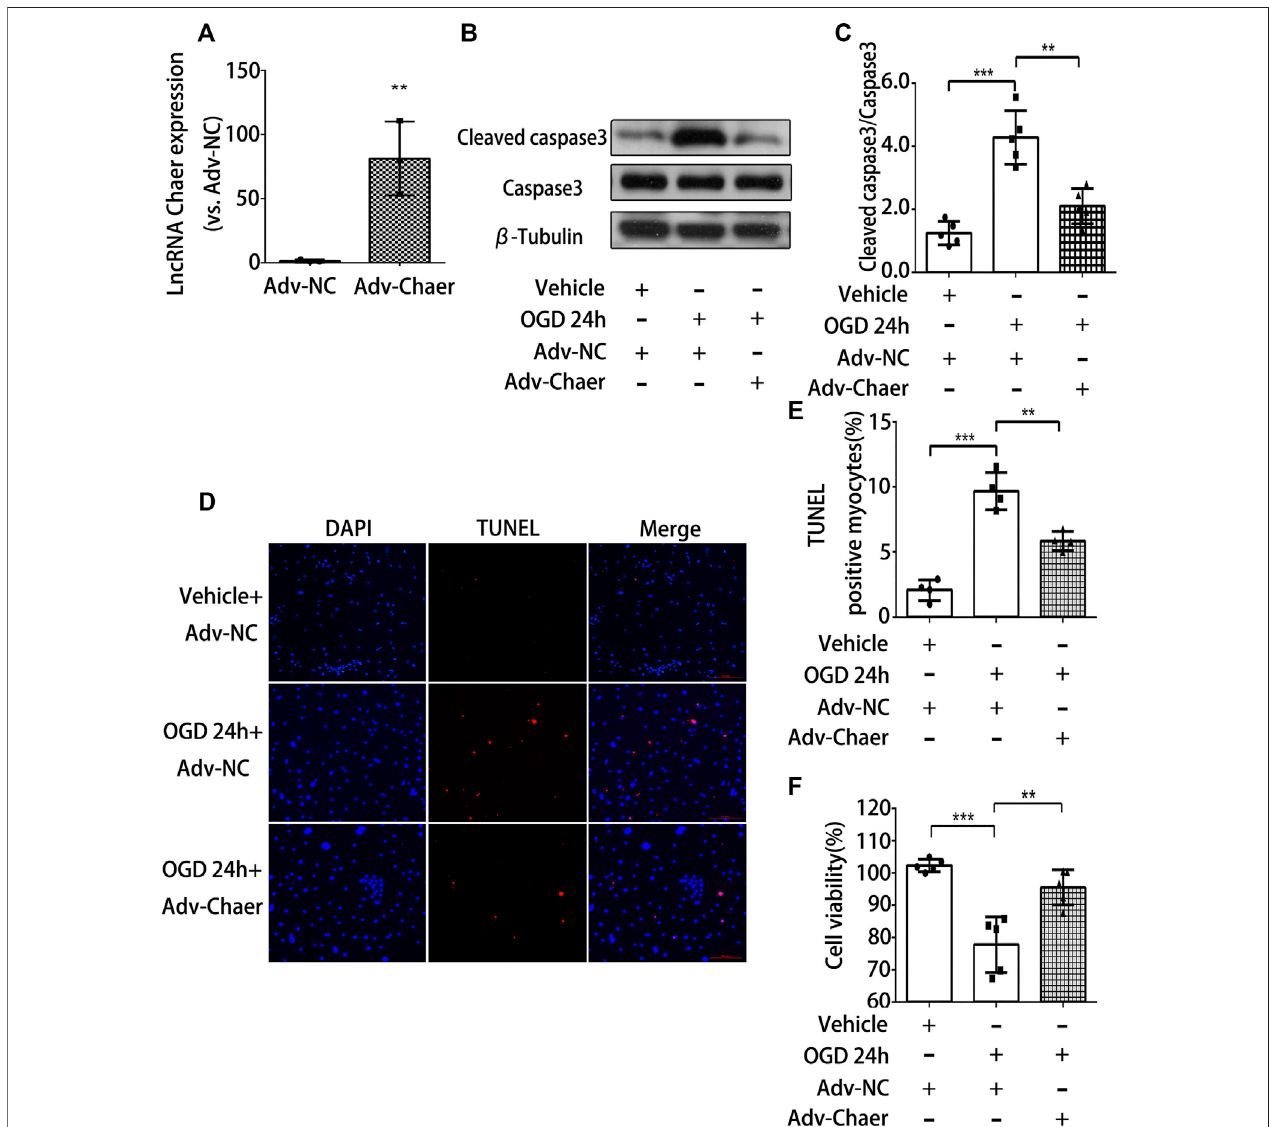
FIGURE 3 | Overexpression of lncRNA Chaer decreases apoptosis in cardiomyocytes treated with OGD. (A) Elevated expression of lncRNA Chaer by Adv-Chaer in cardiomyocytes. **p < 0.01 vs. Adv-NC, n (cid:1) 3. (B, C) After Adv-Chaer/Adv-NC transfection, CMs were treated with OGD for 24 h, then Western blotting was performed to test the expression of Cleaved caspase3 expression in cardiomyocytes. **p < 0.01, ***p < 0.001, n (cid:1) 5 . (D, E) Representative TUNEL-stained images of Adv-Chaer-infected cardiomyocytes after treatments of OGD. Red, TUNEL-positive nuclei; blue, DAPI; scale bar (cid:1) 50 μ m. Quanti fi cation of TUNEL-positive cardiomyocytes. **p < 0.01, ***p < 0.001, n (cid:1) 4. (F) Effect of Adv-Chaer on cell viability after 24h OGD treatments by CCK8 analysis. **p < 0.01, ***p < 0.001, n (cid:1) 5 .